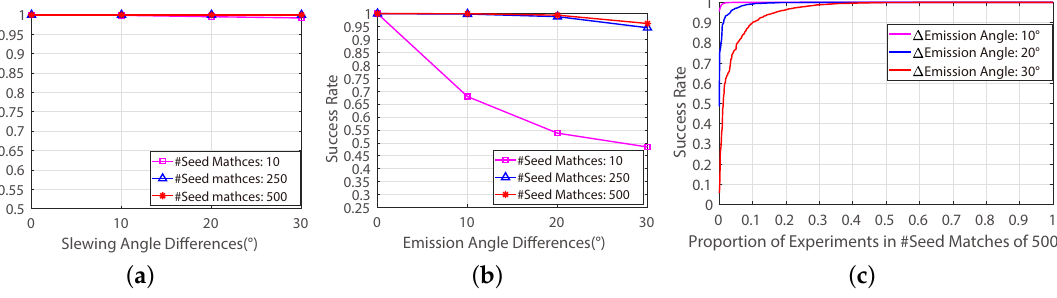
Figure 4. The success rates of the rectification method performed on the 7,000 simulated datasets based on the CDC algorithm. ( a ) The success rates on datasets with various differences of slewing angles. ( b ) The success rates on datasets withe various differences of emission angles. ( c ) The success rates on datasets with 500 seed-matches and various differences of emission